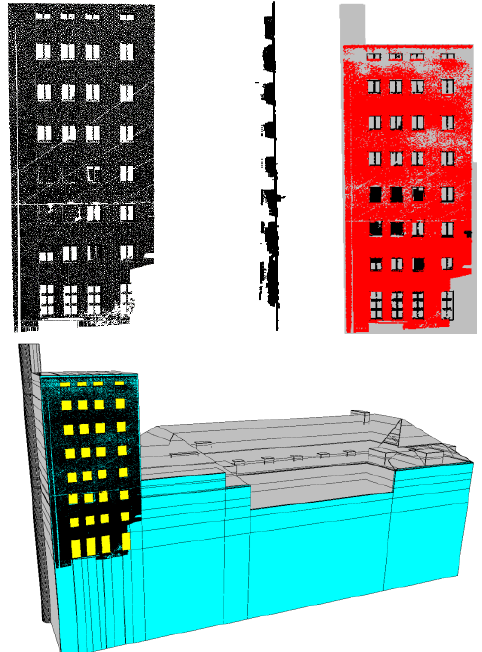
Figure 5. Top left: TLS facade cloud; top middle: profile of top left; top right: segmentation into façade points (red) and non- façade points (black); bottom: result of cell decomposition with reconstructed windows depicted in